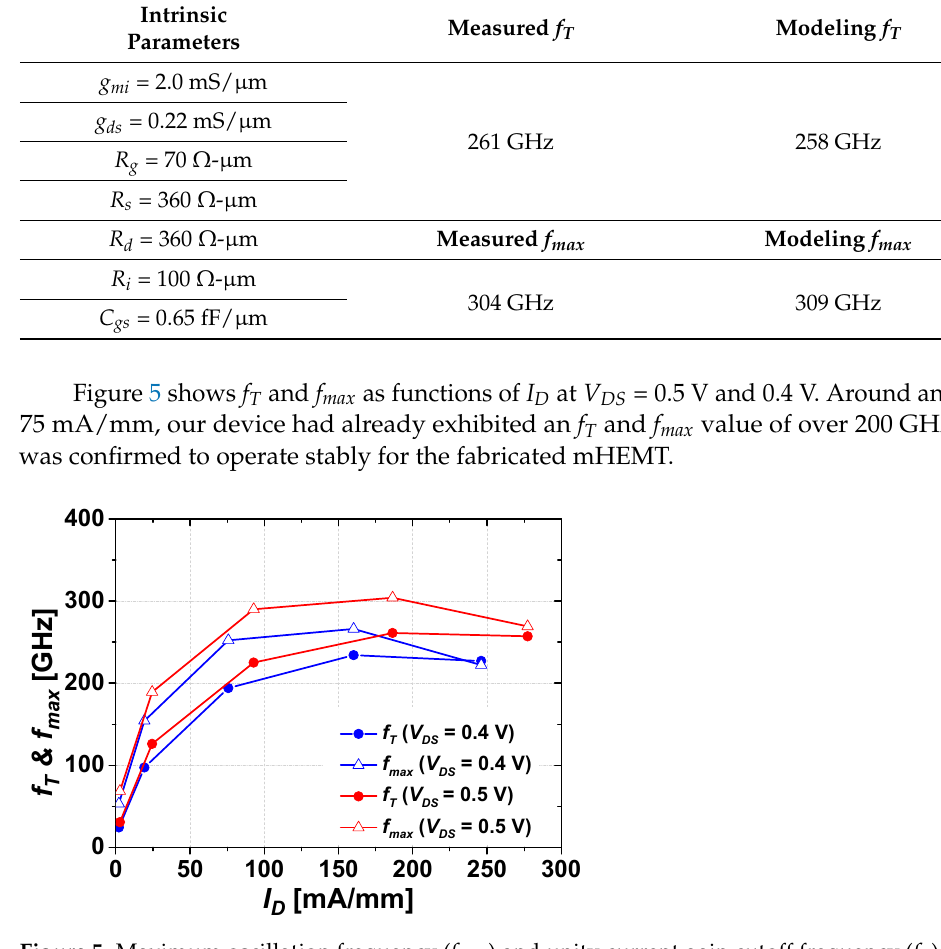
Figure 5. Maximum oscillation frequency ( f max ) and unity current gain cutoff frequency ( f T ) of the mHEMTs against drain current density ( I D ) at a V DS = 0.5 and 0.4 V, respectively.